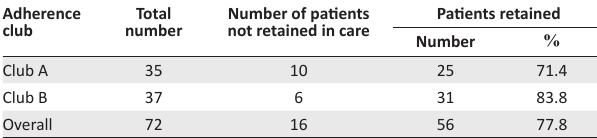
TABLE 4: Retention in care distributions in two adherence clubs at Facility Y.